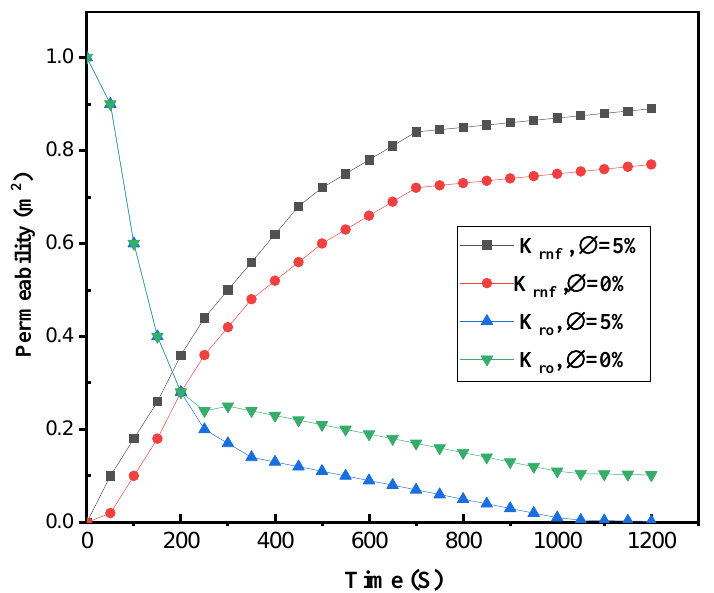
Figure 11. Comparing water/oil relative permeability with null and 5% volumetric nanoparticles in the homogenous porous medium.